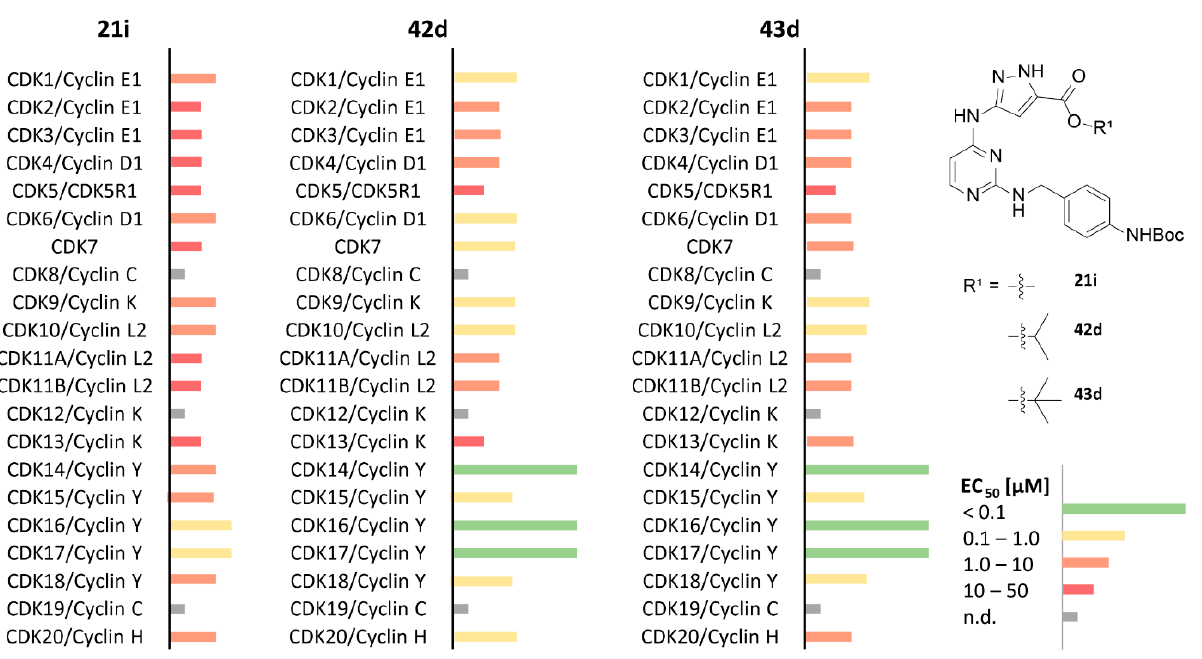
Figure 8. Cellular EC 50 values of 21i , 42d , and 43d against the CDK family were determined using NanoBRET technology in a 11-dose–response curve in duplicates.